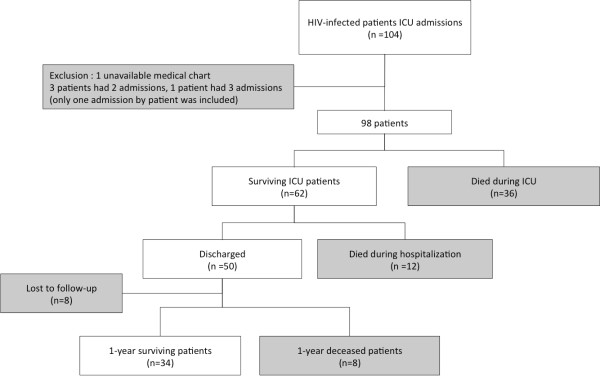
Flow diagram of human immunodeficiency virus (HIV)-infected patients enrolled in the study at Medical Intensive Units of the Montpellier Hospital from 1997 to 2008.